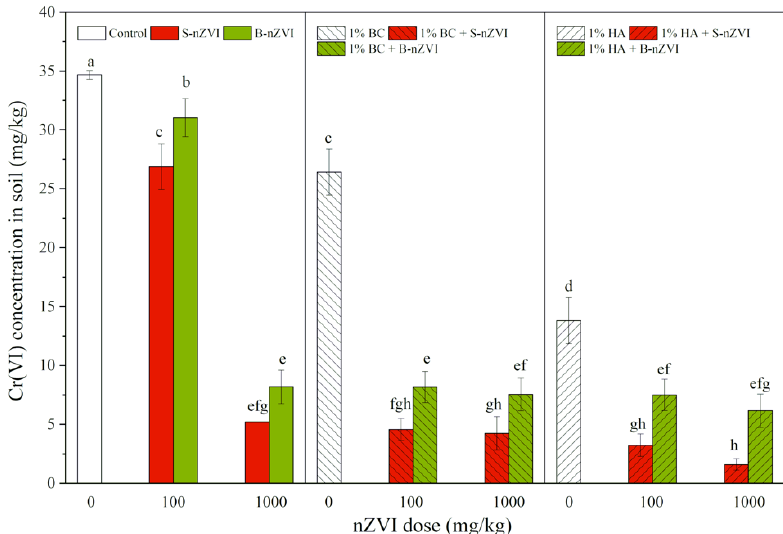
Figure 1. Cr(VI) concentrations (means ± SD, n = 4) in soil with nZVI alone or in combination with biochar (BC) or humic acid (HA). Different letters on the bars indicates significant differences among all means in different treatments using a one-way ANOVA followed by a Duncan’s multiple range test ( p < 0.05). Three-way ANOVA results are shown in Table 2.